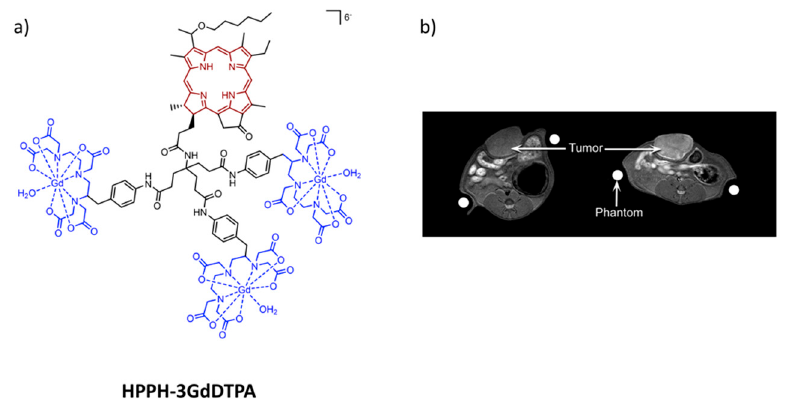
Figure 1. ( a ) Chemical structure of the theranostic compound HPPH-3GdDTPA; ( b ) magnetic resonance (MR) images of a rat (Fischer) bearing Ward colon tumors before (left) and 24 h after (right) injection of HPPH–3-GdDTPA conjugate (dose: 10 µ mol/kg). Adapted with permission from [41]. Copyright 2010 American Chemical Society.